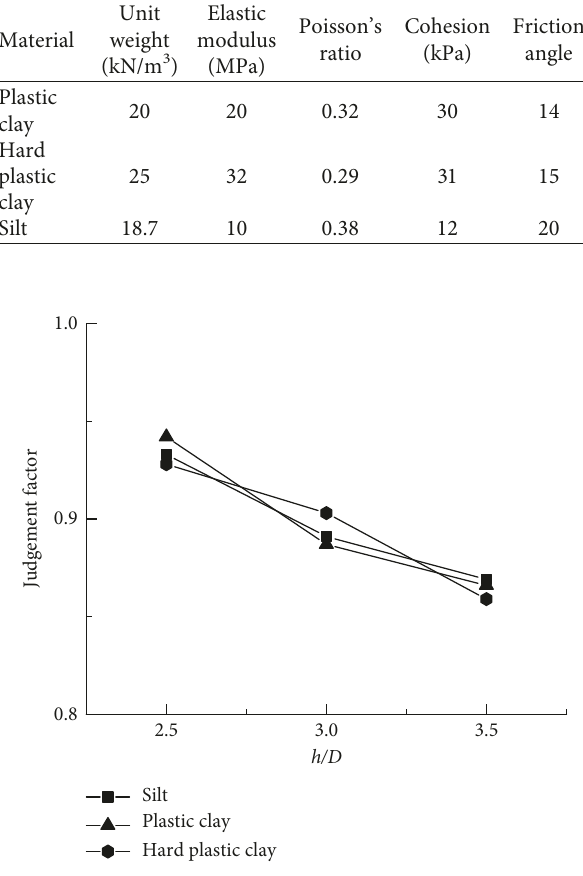
Figure 9: Variation of judgement factor at small ratio.